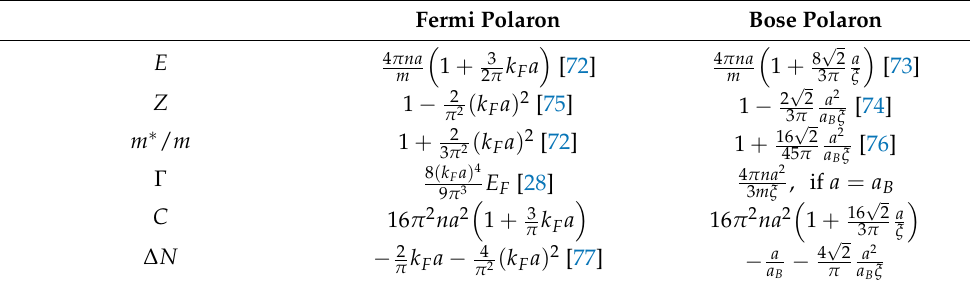
Table 2. Perturbation theory results for quasiparticle properties in the case m = m med , evaluated up to 2nd order in the impurity-medium scattering length. The result for the damping rate Γ refers to the repulsive polaron in the case where we have short-range attractive impurity-medium interactions (see Section